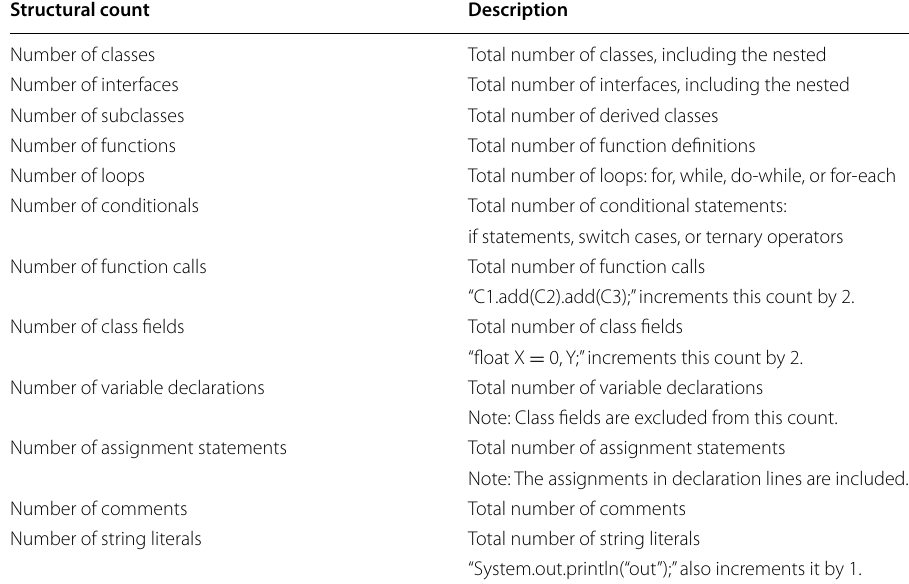
Table 2 The structural counts extracted from each file separately Structural count